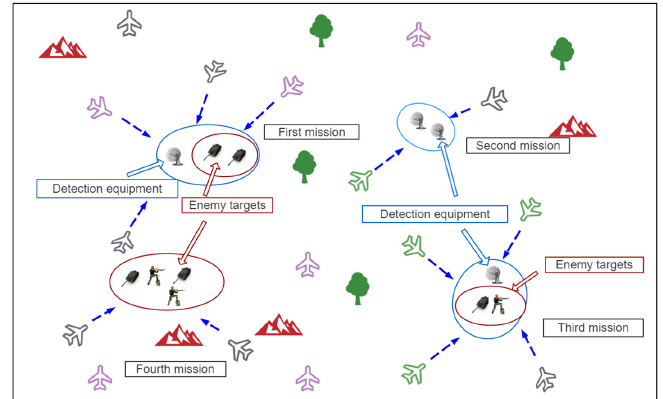
Figure 1. Illustration of mission planning in a large UAV cluster.